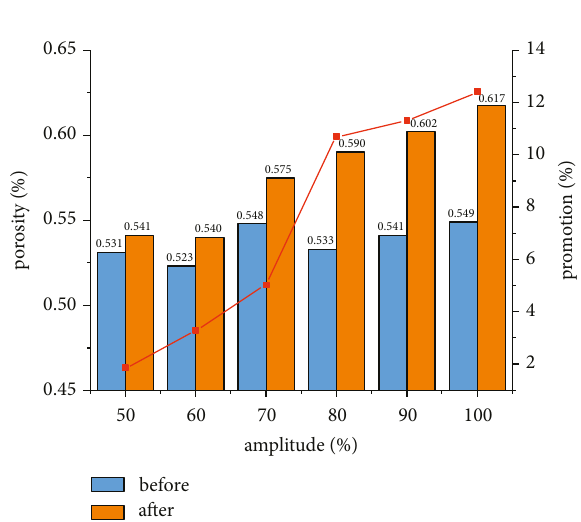
Figure 1: Test equipment and process.